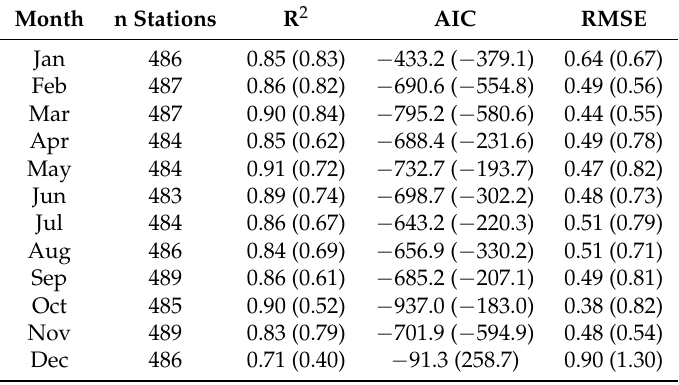
Table 2. Calibration of reconstructed monthly MODIS LST data for 2016 against air temperature data of meteorological stations from the German Weather Service (DWD) and elevation. Values in brackets are the results without elevation as additional explanatory variable. AIC: Akaike information criterion; RMSE: root mean square error.